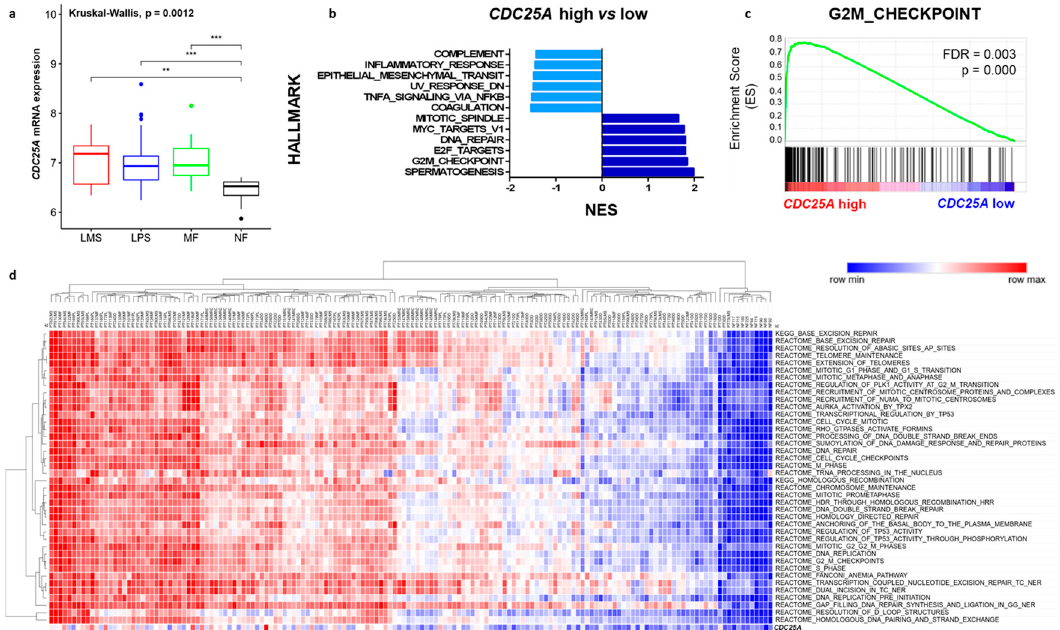
Figure 5. Overexpression of CDC25A mRNA levels in STS is related to cell cycle and DNA repair pathways enrichment. Raw data was collected from the National Center for Biotechnology Information (NCBI)/GenBank GEO web site (GSE21122) and normalized in R using Bioconductor and associated packages. ( a ) For each box plot, median and ranges are indicated. ** p < 0.01 and *** p < 0.001. LMS: Leiomyosarcoma, LPS: Liposarcoma, MF: Myxofibrosarcoma and NF: normal fat. ( b ) Gene Set Enrichment Analysis (GSEA) table summarizing the enrichment in gene signatures (hallmarks) in CDC25A high versus low STS patient samples. Samples were separated in two groups: CDC25A high and CDC25A low (based on Q1/Q4 distribution) and GSEA was used to analyze gene signatures and pathways enrichment. Enrichment Score (ES) reflects the degree to which a gene set is overrepresented at the top or bottom of a ranked list of genes. The normalized enrichment score (NES) is the primary statistic for examining gene set enrichment results and can be used to compare analysis results across gene sets. Gene sets were selected by their statistical significance filtered by FDR q-value < 0.25 and Nom p -value < 0.05. ( c ) Snapshots of G2M Checkpoint gene set significantly enriched in CDC25A high STS patient samples. ( d ) Heatmap of top 40 enriched Canonical pathways gene sets derived from the KEGG and Reactome pathways databases from MSigDB in STS samples determined by single-sample Gene Set Enrichment Analysis (ssGSEA). Each ssGSEA enrichment score represents the degree to which the genes in a particular gene set are coordinately up- or down-regulated within a sample.